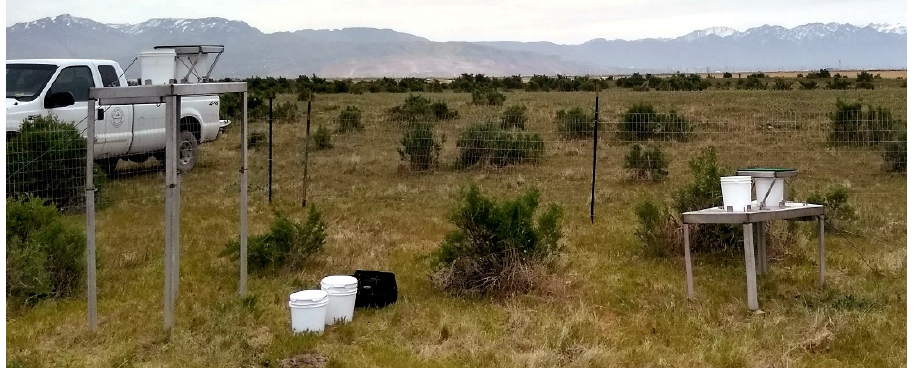
Figure 4. High (~2 m) sample table on the left and the low (~1 m) sample table on the right.